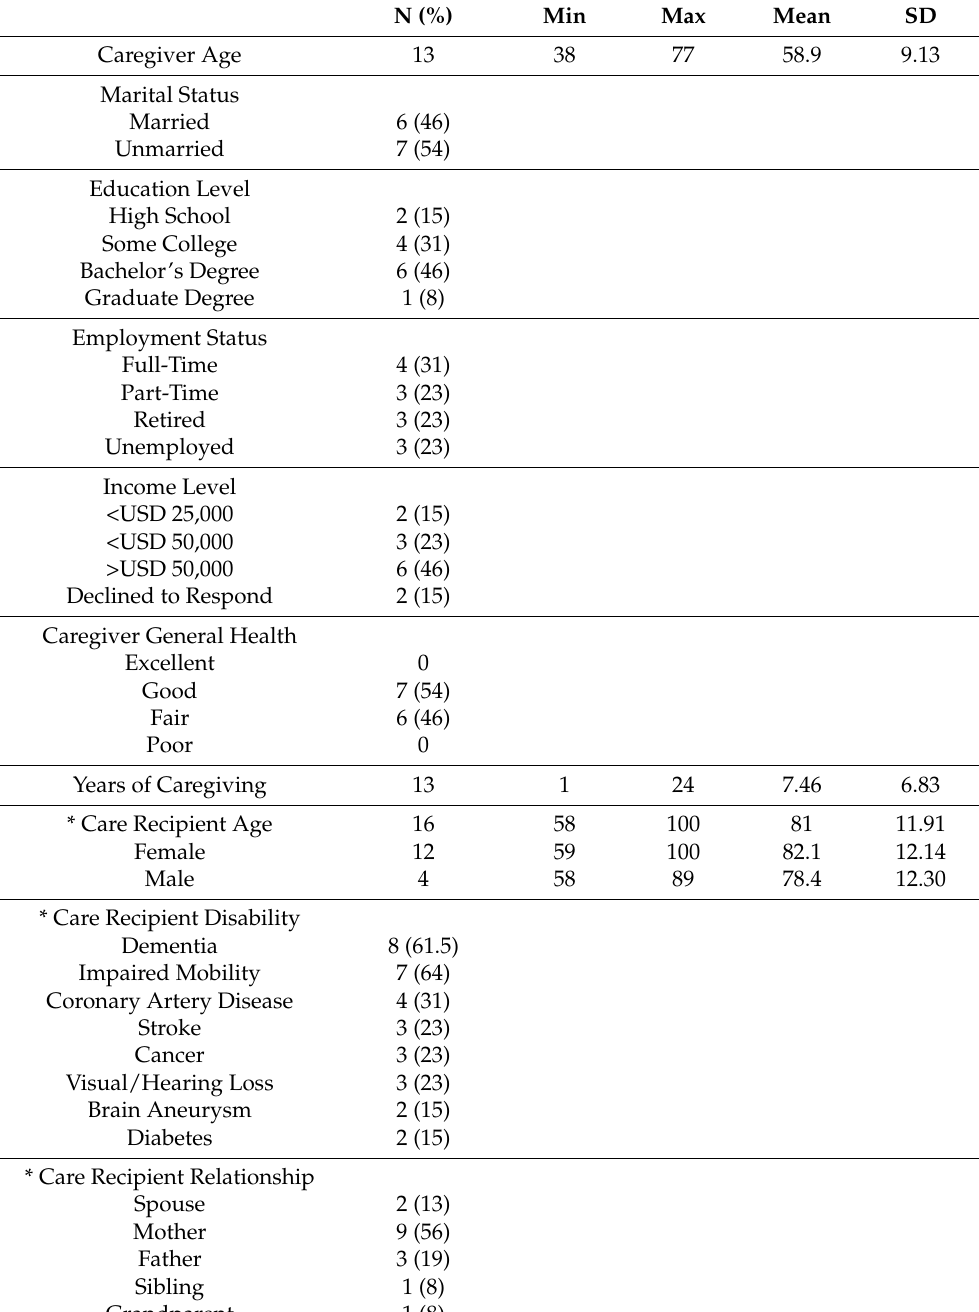
Table 2. Caregiver and care recipient